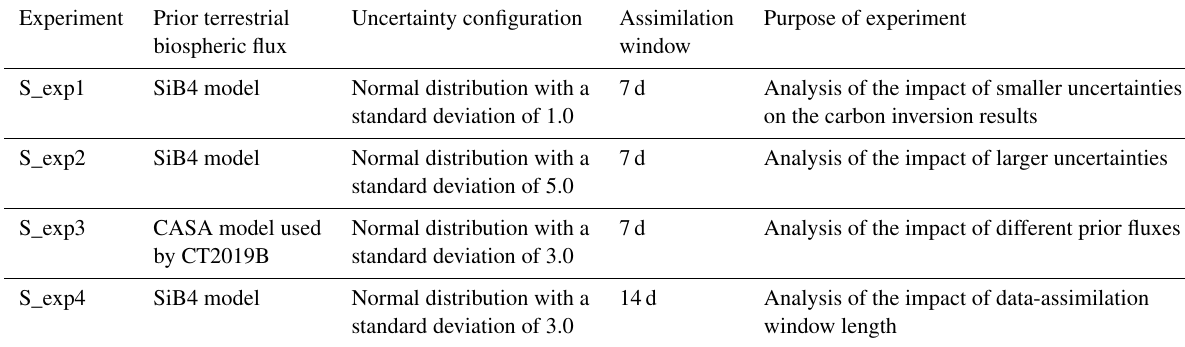
Table 2. Sensitivity inversion experiments conducted in this study. Experiment Prior terrestrial Uncertainty configuration Assimilation Purpose of experiment biospheric flux window S_exp1 SiB4 model Normal distribution with a 7d Analysis of the impact of smaller uncertainties standard deviation of 1.0 on the carbon inversion results S_exp2 SiB4 model Normal distribution with a 7d Analysis of the impact of larger uncertainties standard deviation of 5.0 S_exp3 CASA model used Normal distribution with a 7d Analysis of the impact of different prior fluxes by CT2019B standard deviation of 3.0 S_exp4 SiB4 model Normal distribution with a 14d Analysis of the impact of data-assimilation standard deviation of 3.0 window